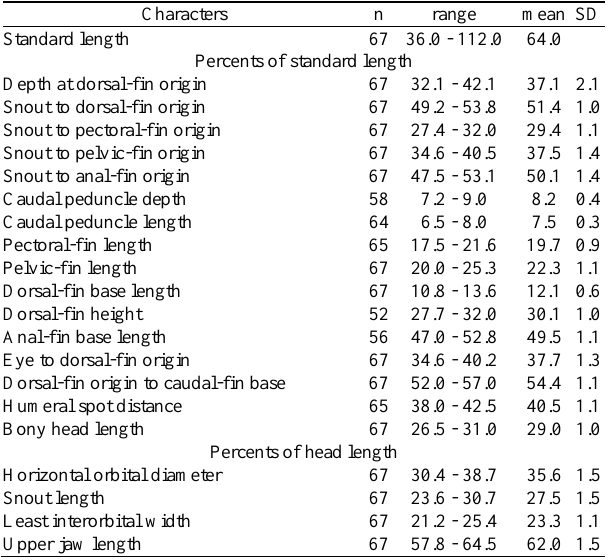
Table 13 . Morphometrics of Charax pauciradiatus . Specimens are from MZUSP 26562, 33418, 20562, 83763, 62114, 60391, MCP 22537,